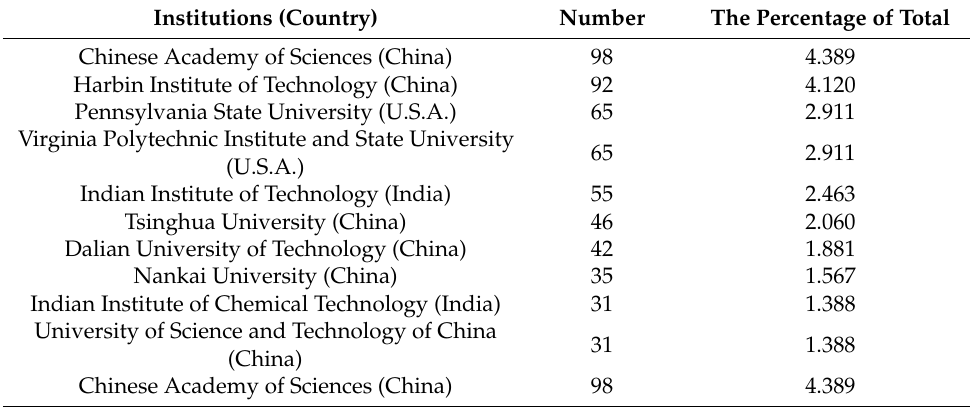
Table 4. The top 10 most productive institutions on MFCs in wastewater treatment.